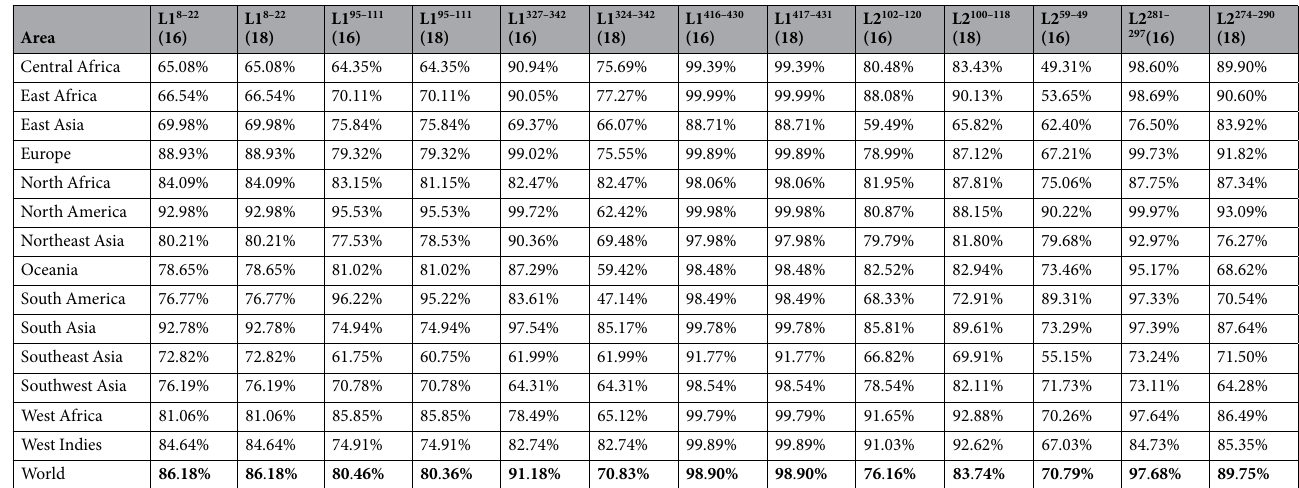
Table 10. Population coverage of putative HPV L1 and L2 helper T-cell